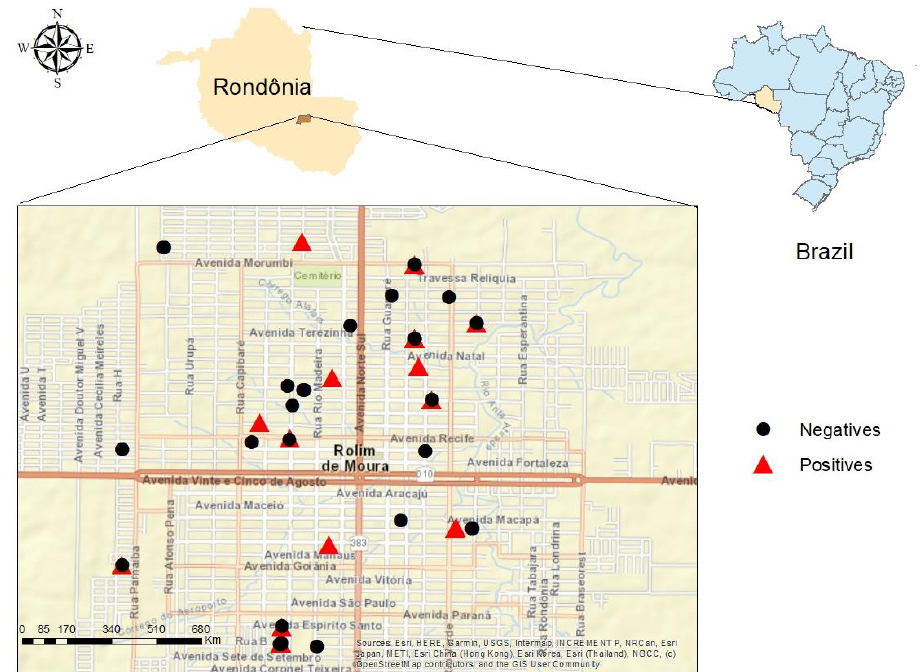
Figure 1. Geographical location of the municipality of Rolim de Moura, state of Rondônia, Brazil. Place of origin of cats and spatial distribution between seropositive and seronegative for anti- T. gondii antibodies .